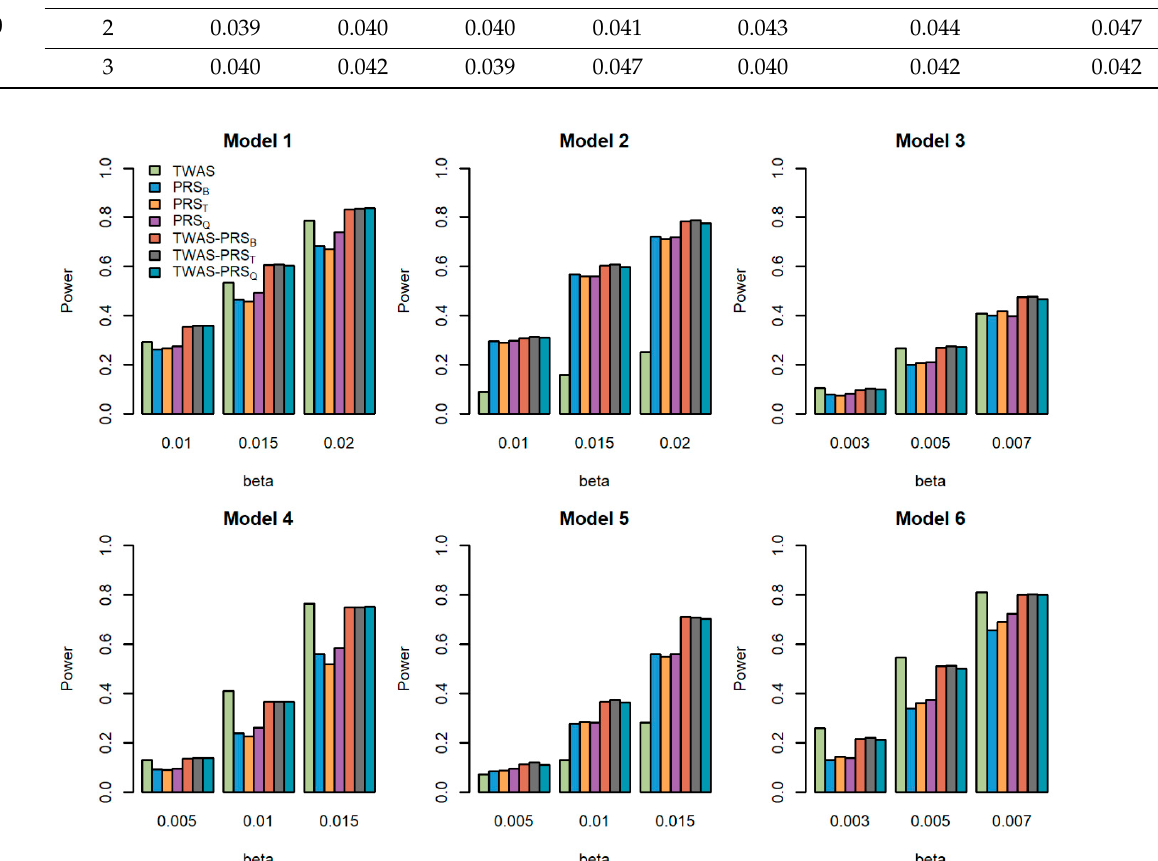
Figure 1. Powers of the seven tests versus the total effect size β for quantitative traits with N = 5000. The proportion of causal variants is 0.2. Models 1–3 correspond to genes 1–3, for which we only used the eQTL with the largest weight to generate gene expression; Models 4–6 cor- respond to genes 1–3, for which we used the two eQTLs with the first two largest weights to generate gene expression.